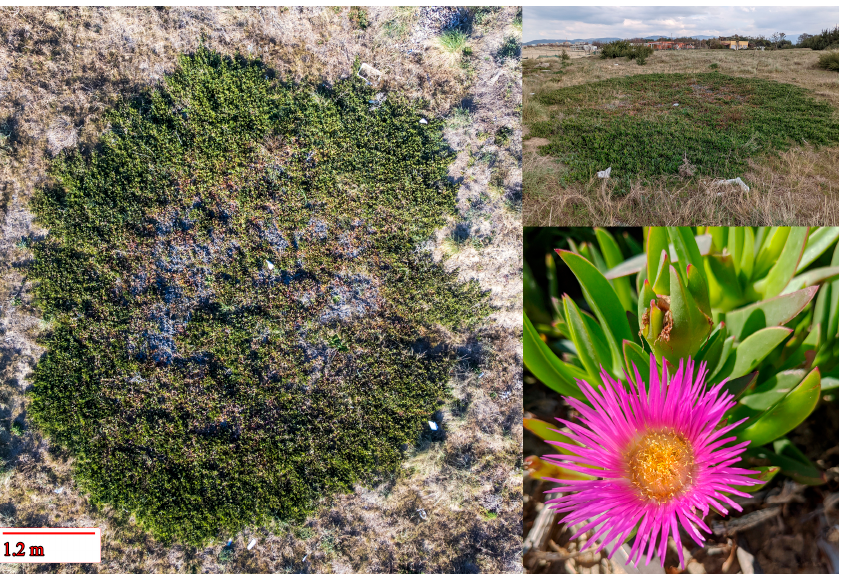
Figure 1. UAV image of a single patch of Carpobrotus about 6 m in diameter, with details of the plant as a whole, the green parts, and the flowers. Pictures by Michele Innangi.